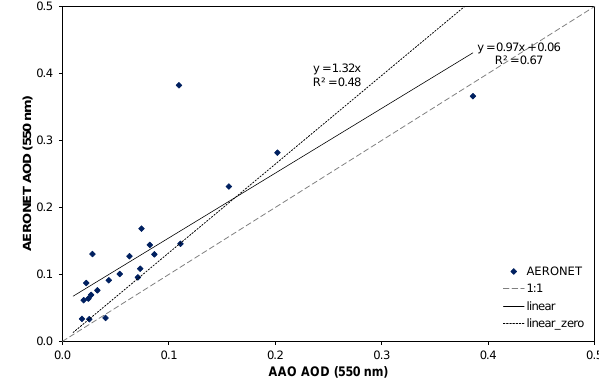
Fig. 6. Comparison of AAO aircraft calculated aerosol optical depth with AERONET optical depth (adjusted to 550nm) for flights that have a RH < 60% for all 11